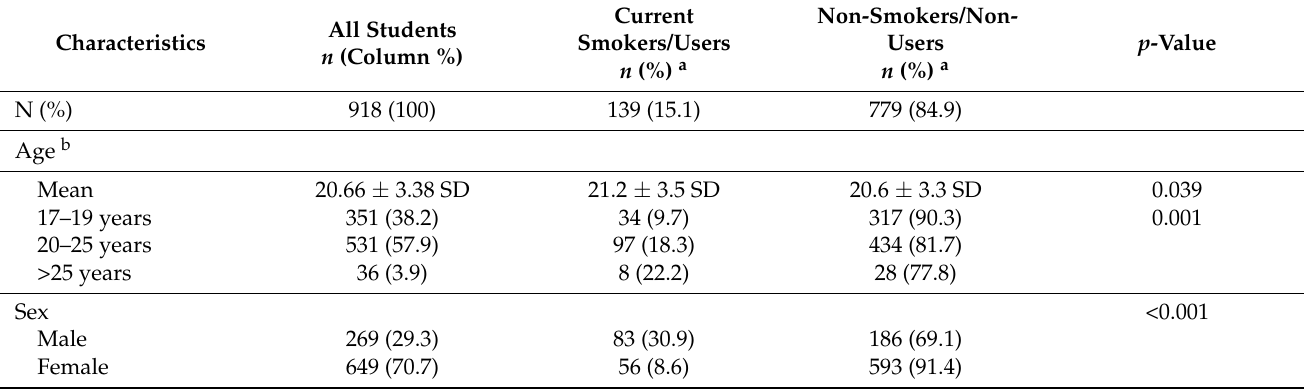
Table 1. Characteristics of participating students by their current smoking status (smoker, non-smoker).